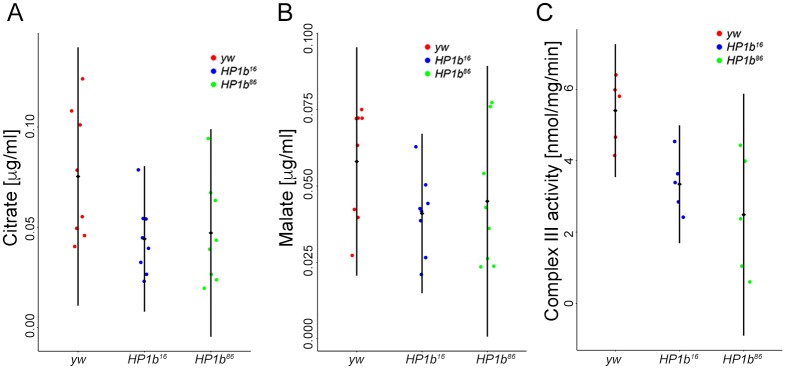
Krebs cycle metabolites and mitochondrial complex III activity are impacted by loss of HP1B.A&B. Assay of Krebs cycle metabolites by mass spectroscopy reveals that citrate (A) and malate (B) levels are lower in HP1b mutants. X-axis: Genotypes. Y-axis: Metabolite levels in μg/ml. n = 4 per sex and genotype. C. Mitochondrial function assays indicate that Complex III activity is reduced in HP1b mutant animals (males). X-axis: Genotypes. Y-axis: enzyme activity in mmol/mg/min. n = 5 per genotype.